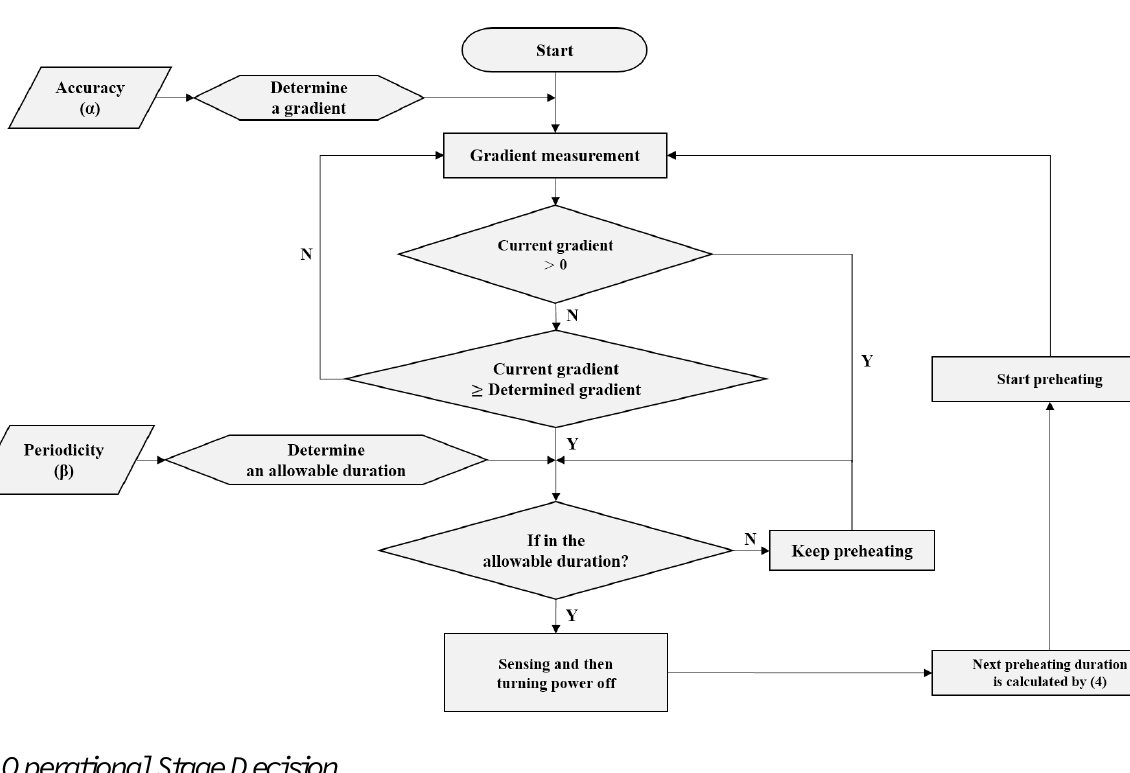
Figure 5. Flow of sensing time